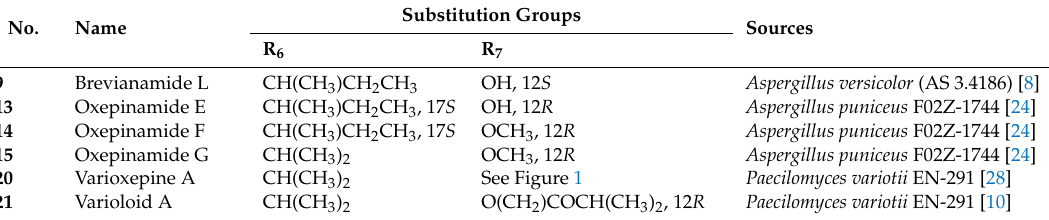
Table 2. Structures and Biological sources of Type B Oxepine-Pyrimidinone-Ketopiperazine NRPs. No.